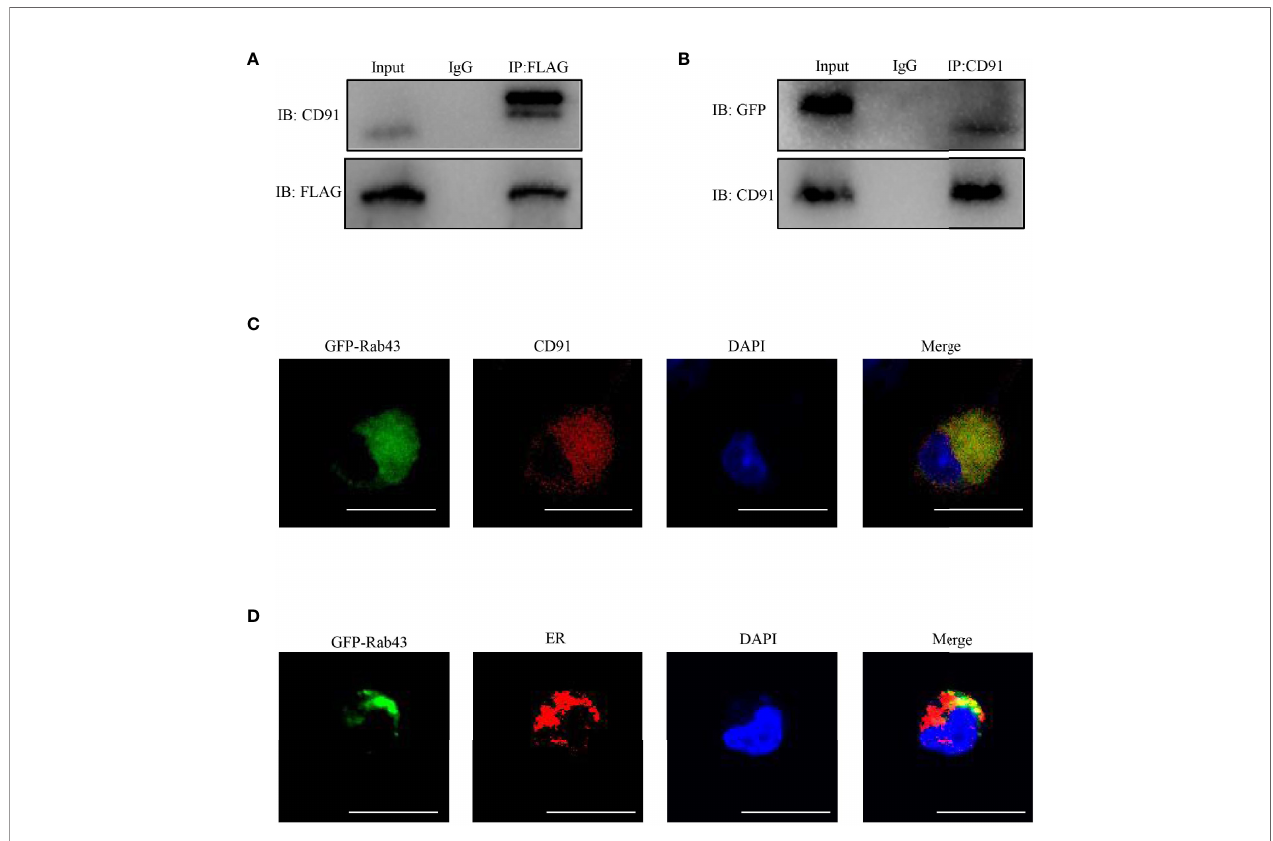
FIGURE 7 | Rab43 directly interacts with CD91. (A, B) Co-immunoprecipitation of Rab43 with CD91. (Left panel) RAW264.7 cells were transfected with the pcDNA3.1-3x fl ag-Rab43 plasmid, and the cell lysates were co-immunoprecipitated with anti-FLAG antibody and then immunoblotted with anti-CD91 antibody. (Right panel) RAW264.7 cells were transfected with the pcDNA3.1-GFP-Rab43 plasmid, and the cell lysates were co-immunoprecipitated with anti-CD91 antibody and then immunoblotted with anti-GFP antibody. (C, D) RAW264.7 cells were transfected with plasmids expressing GFP-Rab43 WT and subsequently incubated with anti- CD91 antibody or anti-Calnexin antibodies. Green, GFP-Rab43-C; red, CD91 or Calnexin; blue, DAPI. Scale bars = 10.0 m